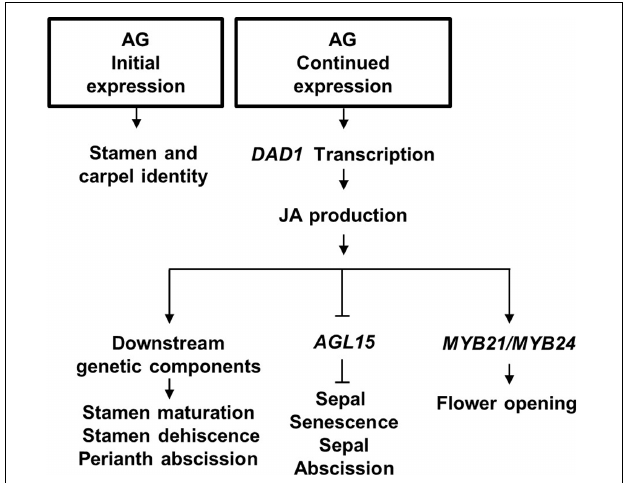
FIGURE 6 | Proposed model for Arabidopsis flower development. Initial AGAMOUS (AG) expression is required for stamen and carpel identity of the innermost whorls of the flower, whereas its late expression causes Jasmonic acid (JA) synthesis in the mature stamens by directly binding to the JA production DAD1 gene. JA in the flower ensures stamen maturation, and stamen dehiscence. JA is proposed to derepress sepal senescence and abscission by inhibiting AGL15